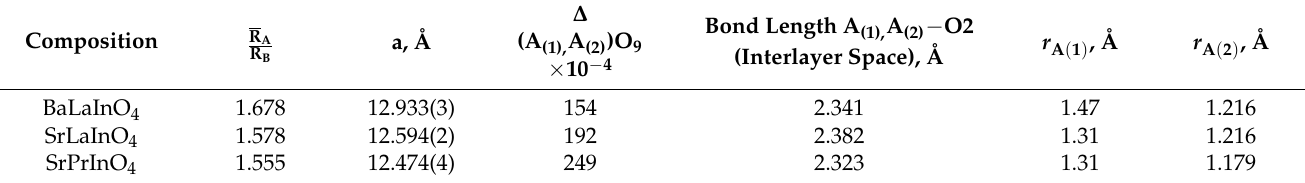
Table 2. Some structural characteristics of layered perovskites, obtained by Titiov et al. [86].